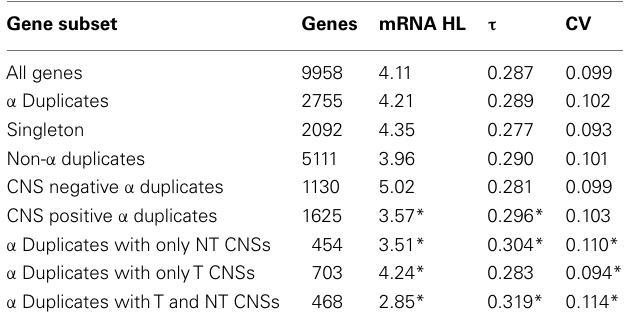
Table 1 | Gene expression characteristics of Arabidopsis gene subsets.